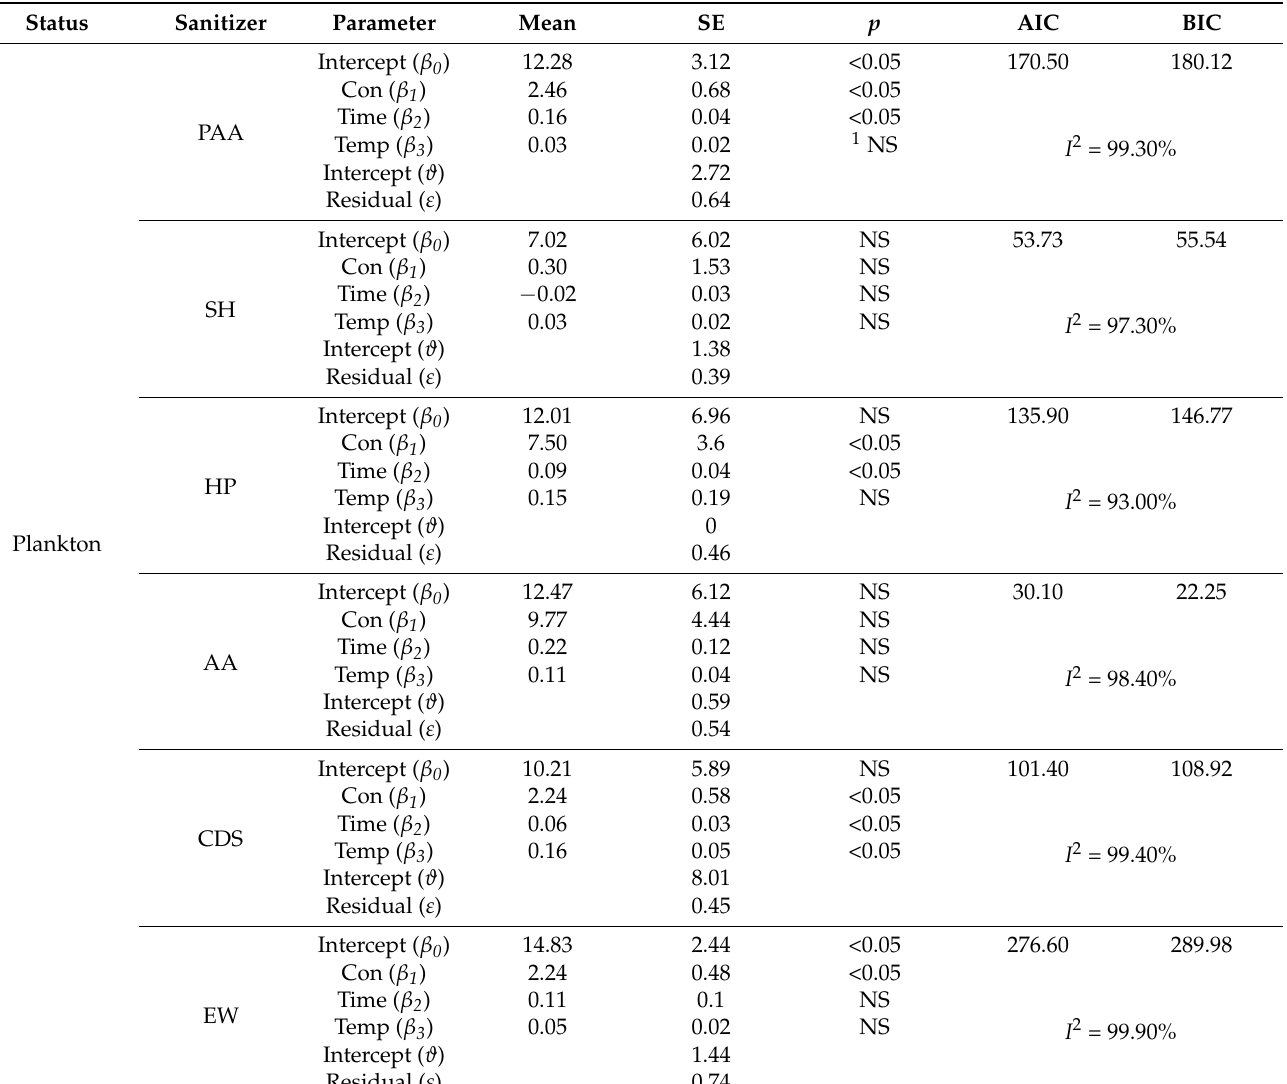
Table 2. Estimated parameters of the mixed-effects models by L. monocytogenes biofilm